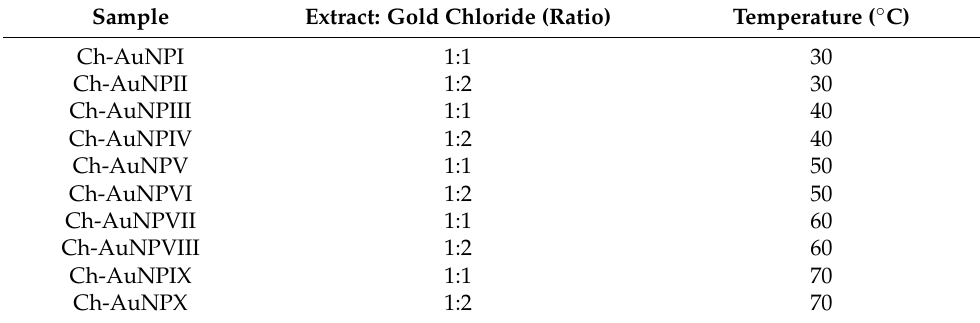
Table 3. Ch-AuNPs synthesis